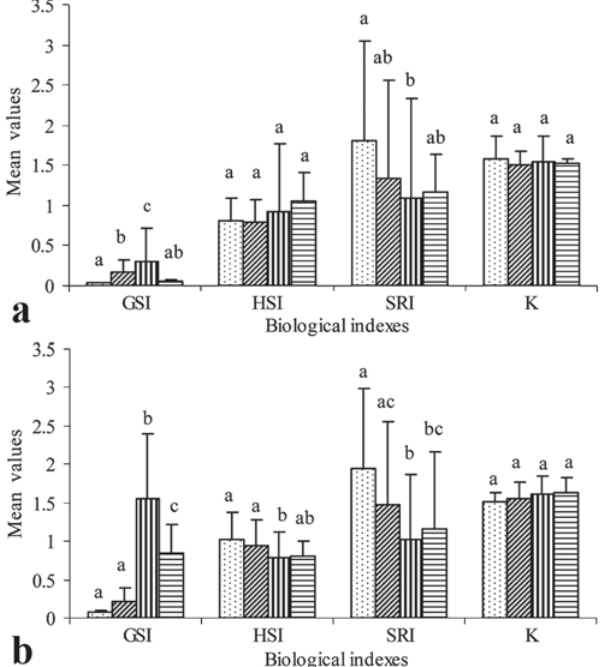
Fig. 3. Mean values ± SD of the gonadosomatic (GSI), hepatosomatic (HSI), stomach repletion (SRI) and condition factor (K) indexes according to gonadal maturation stages of males (a) and females (b) of Cichla piquiti sampled during the period from December 2004 to November 2005 [resting (dotted), initial maturation (oblique lines), advanced maturation (vertical lines), partially spent (horizontal lines)]. Values followed by different letters above the bars of each index are significantly different (one-way ANOVA, p <